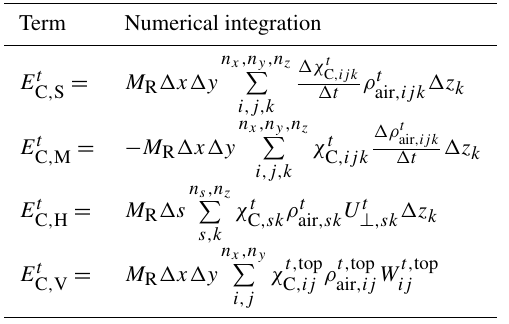
Table B1. Discrete integral expressions of Eqs. (4), (5), (B1) and (B3) to be substituted in Eq. (7). Constants (cid:49)x , (cid:49)y and (cid:49)s are equal to model grid resolution in the horizontal, 2.5km. t is the time index; i , j and k are the 3D-space indices and s is the path index around the box. Term